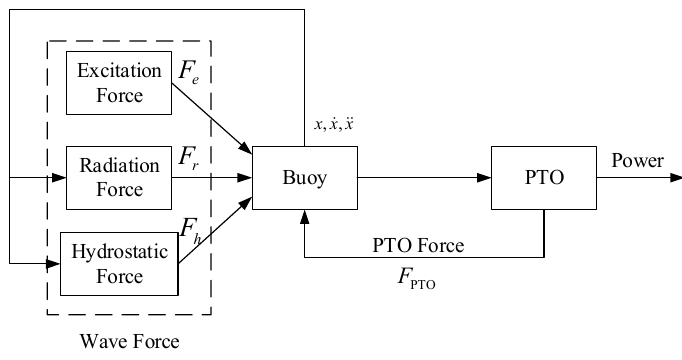
Figure 2. The force composition analysis of the Wave Energy Converter (WEC).